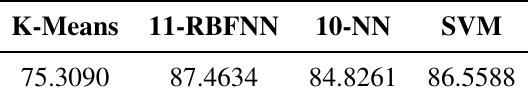
Table 5. Best overall accuracies with each classifier (values in %). RBFNN, radial basis function neural network; NN, nearest neighbor; SVM, support vector